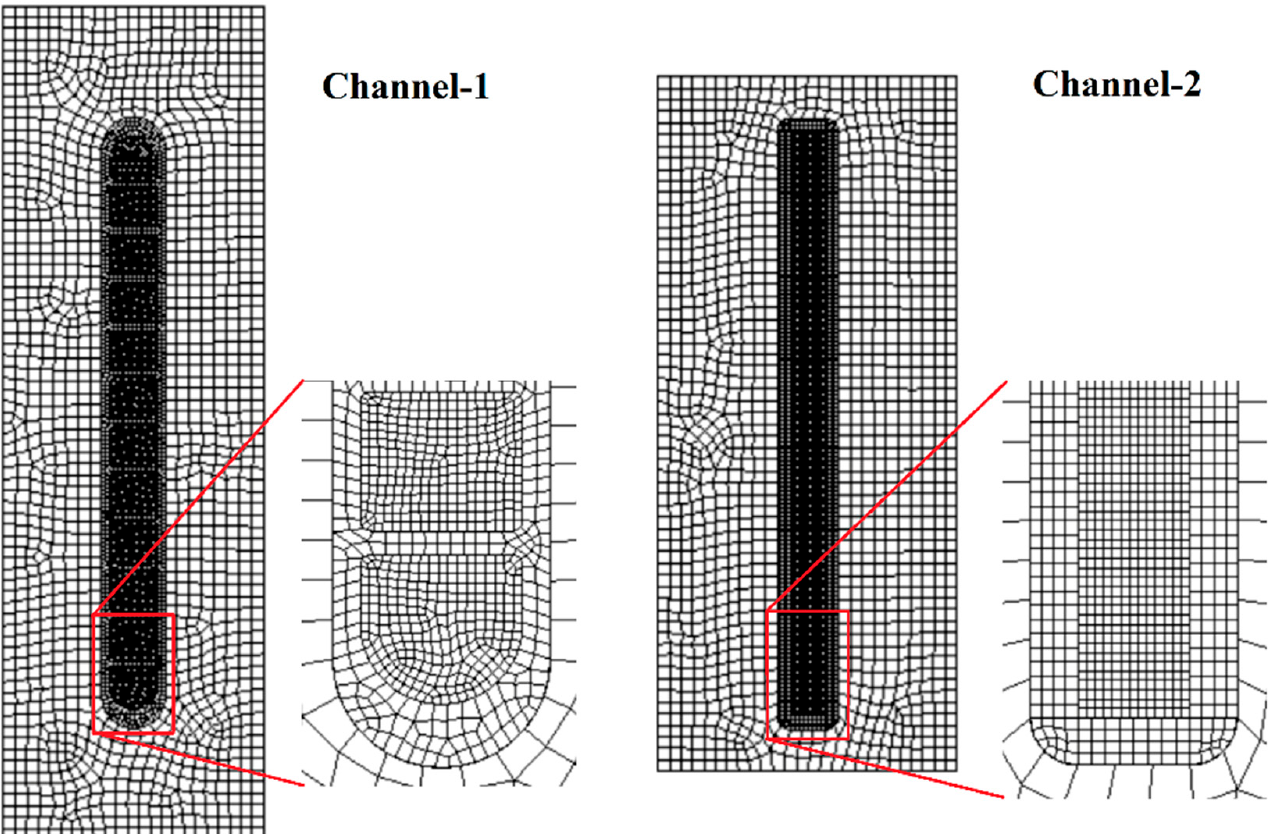
Figure 5. Examples of meshed simulation domains for channel-1 (5 × 16, PF = 82.4%) and channel-2 (6 × 14, PF = 82%).